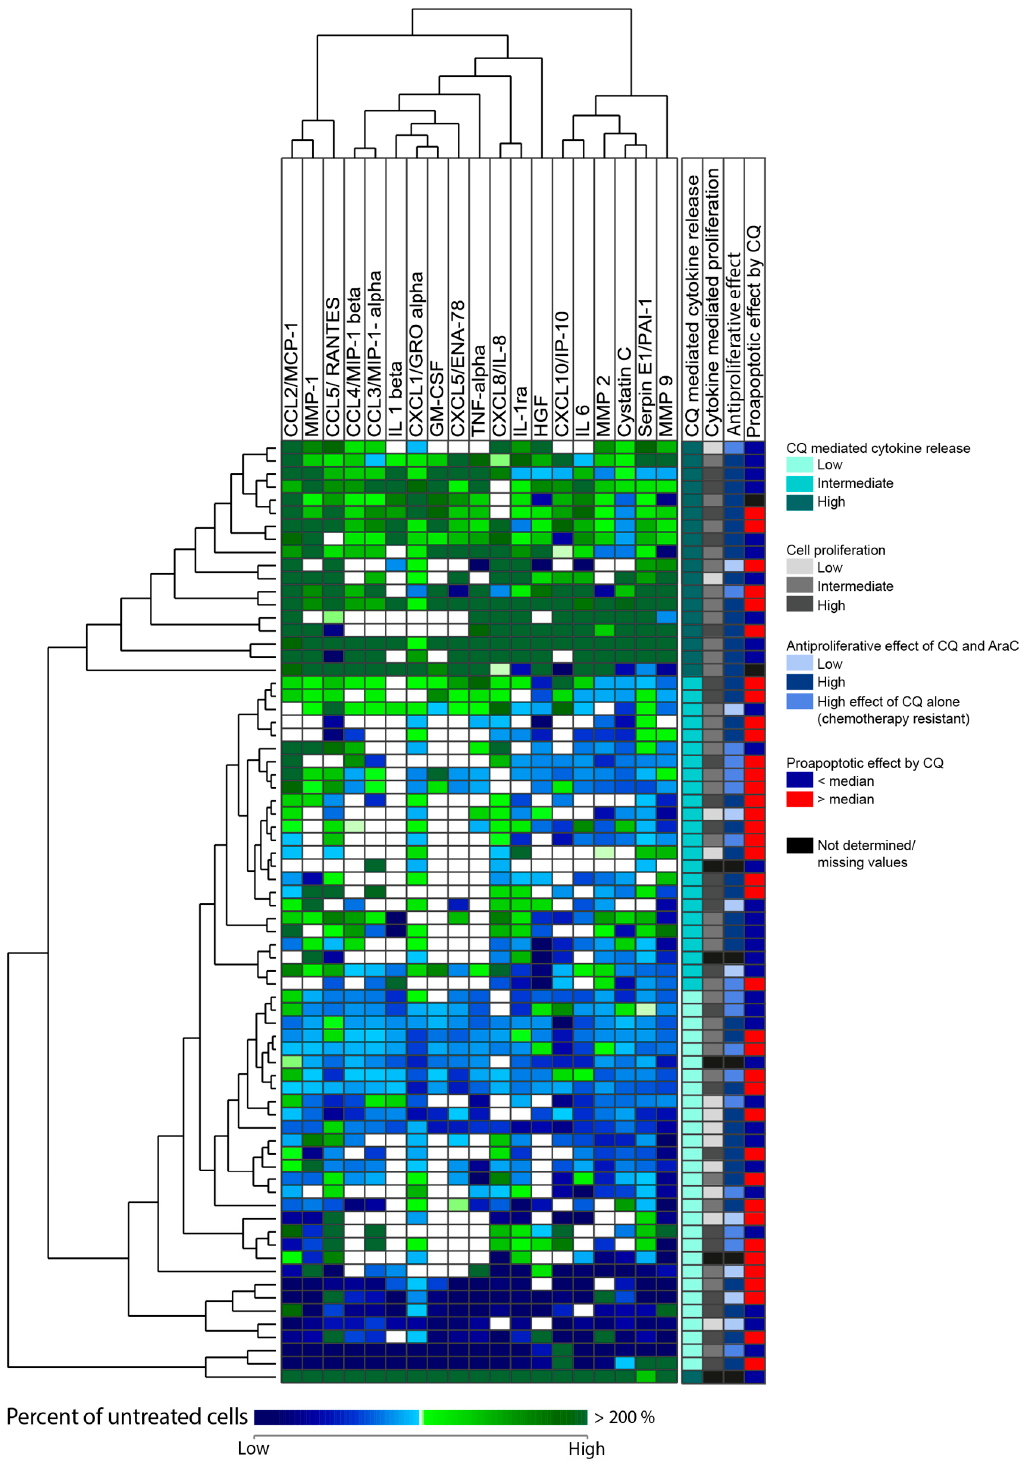
Figure 6. (page 15). Unsupervised hierarchical cluster analysis based on alterations in the release of soluble mediators by primary AML cells derived from 72 unselected patients after treatment with 5 µM chloroquine (CQ) for 48 h. Primary AML cells were cultured with 5 µM chloroquine or medium alone for 48 h, before the levels of soluble mediators in harvested supernatants were determined using Luminex analysis. A hierarchical cluster analysis was performed based upon the alteration of soluble mediators compared to untreated controls (control set to 100%). The cluster analysis identified